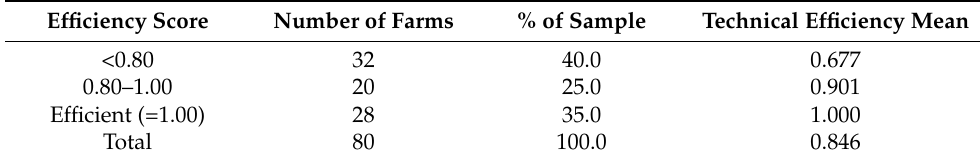
Table 5. Frequency distribution of technical efficiency estimates from the DEA model. Efficiency Score Number of Farms % of